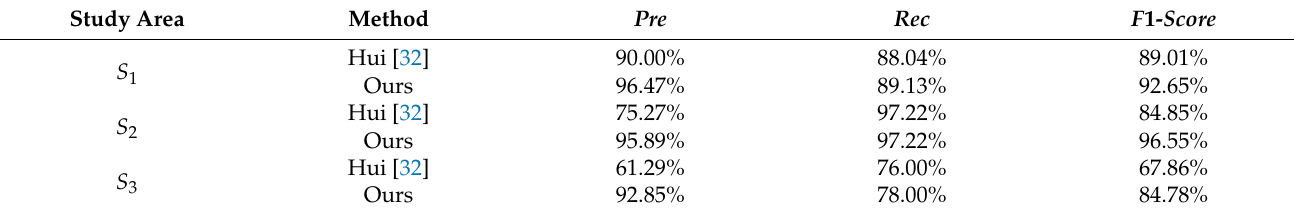
Table 5. Comparison of precision evaluation